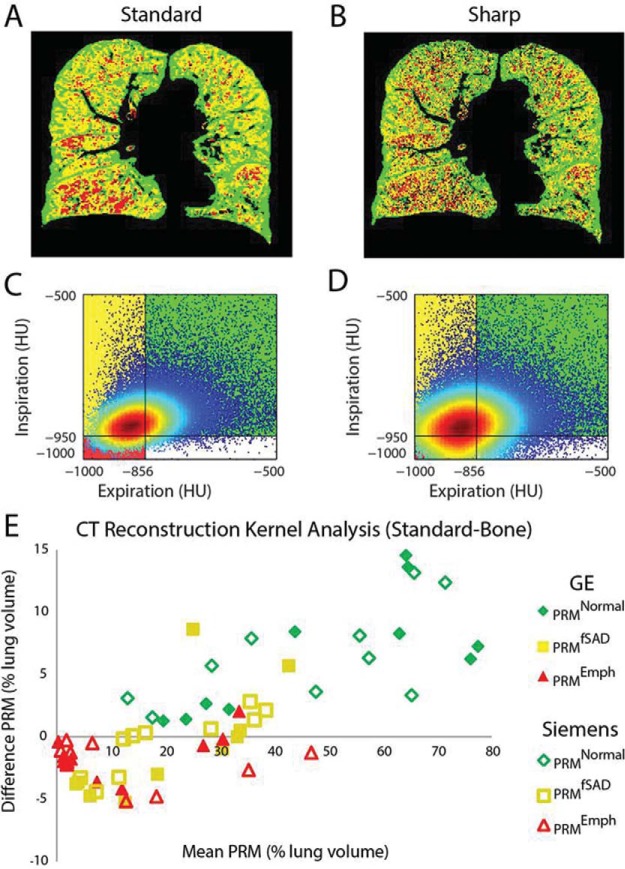
Impact of reconstruction kernels on PRM. Standard kernel reconstruction results in the smoothing of PRM (A) compared with a bone reconstruction (B). The noisier sharp reconstruction results in a broader distribution for the HU joint-density histogram (D) than the standard reconstruction (C). Bland–Altman analysis (E) shows that standard reconstructions result in an increase in PRMNormal and decrease in PRMEmph classifications relative to bone reconstructions regardless of scanner type. PRMfSAD, however, is reduced in mild COPD but increases in more severe diseases with standard compared to bone reconstructions for both scanner types.